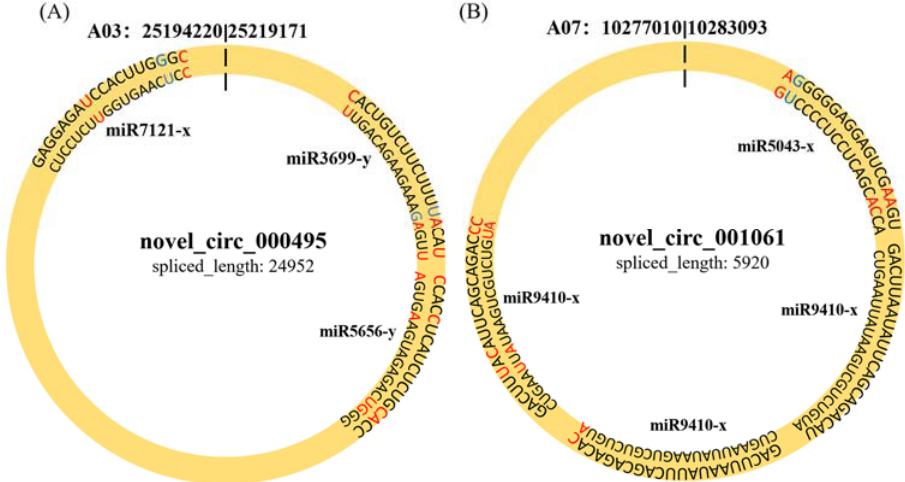
Figure 5. The character of sequence pairing structure between circRNA and their target